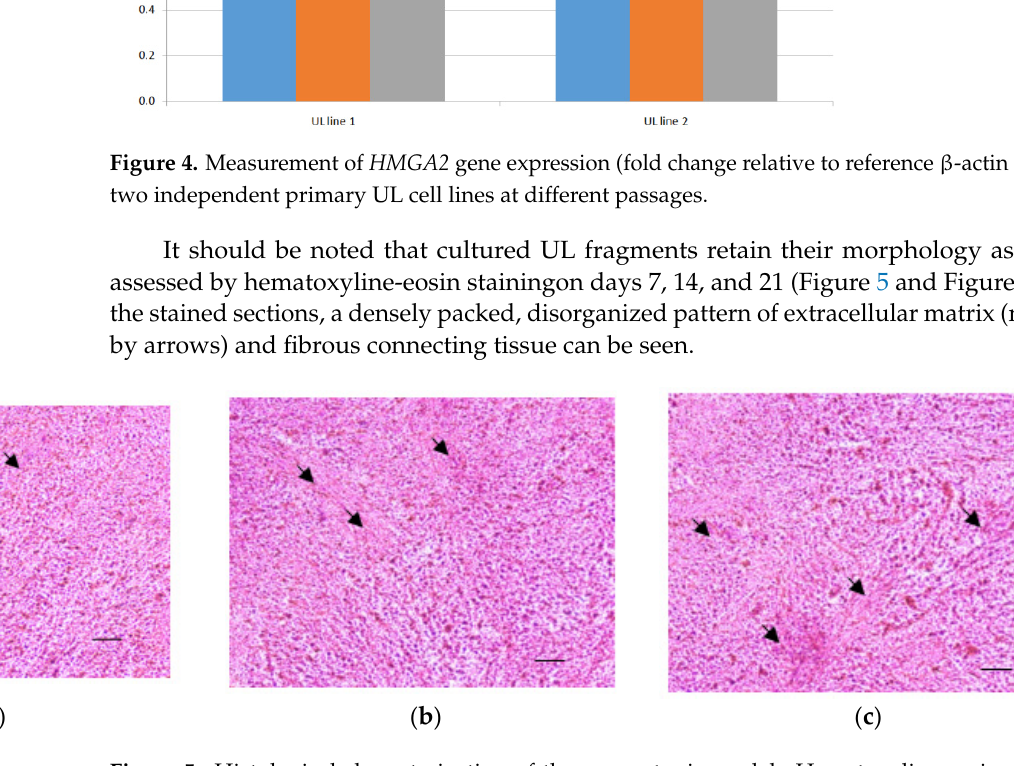
Figure 5. Histological characterization of the organotypic model. Hematoxyline-eosine stained cryosections of UL frag- ments after 7 ( a ), 14 ( b ), and 21 ( c ) days of culture (magnification × 100; scale bar is 200 µm). Arrows mark extracellular